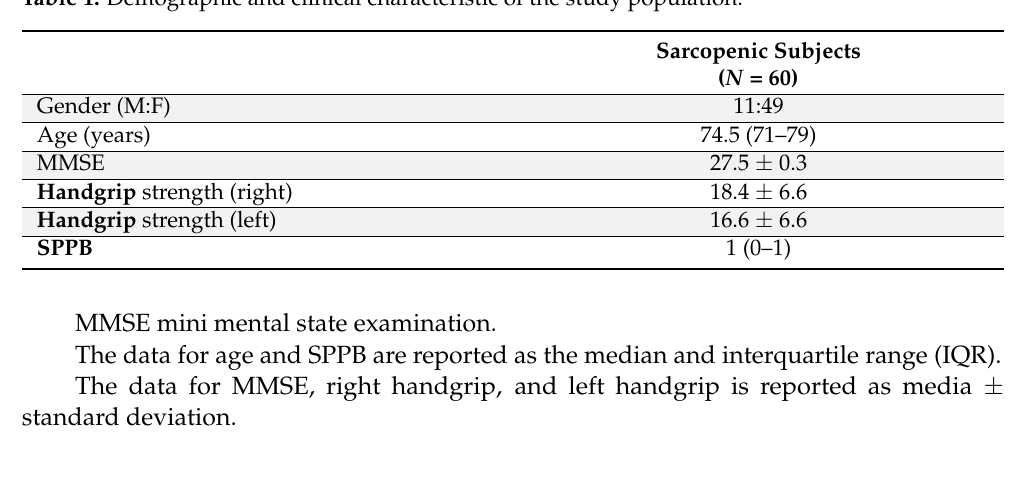
Table 1. Demographic and clinical characteristic of the study